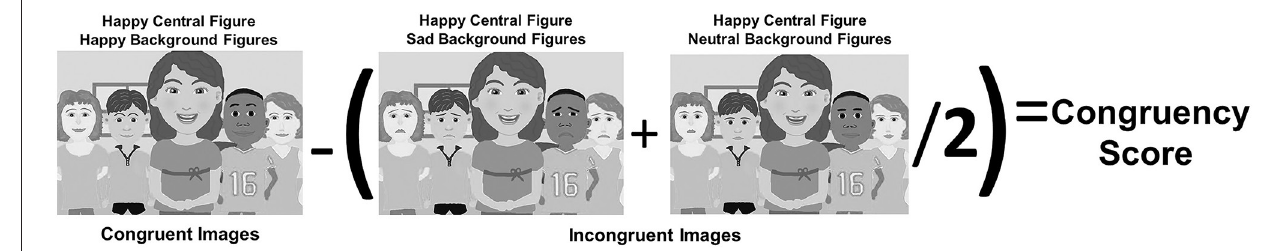
FIGURE 2 | Formula used for computing the congruency score.